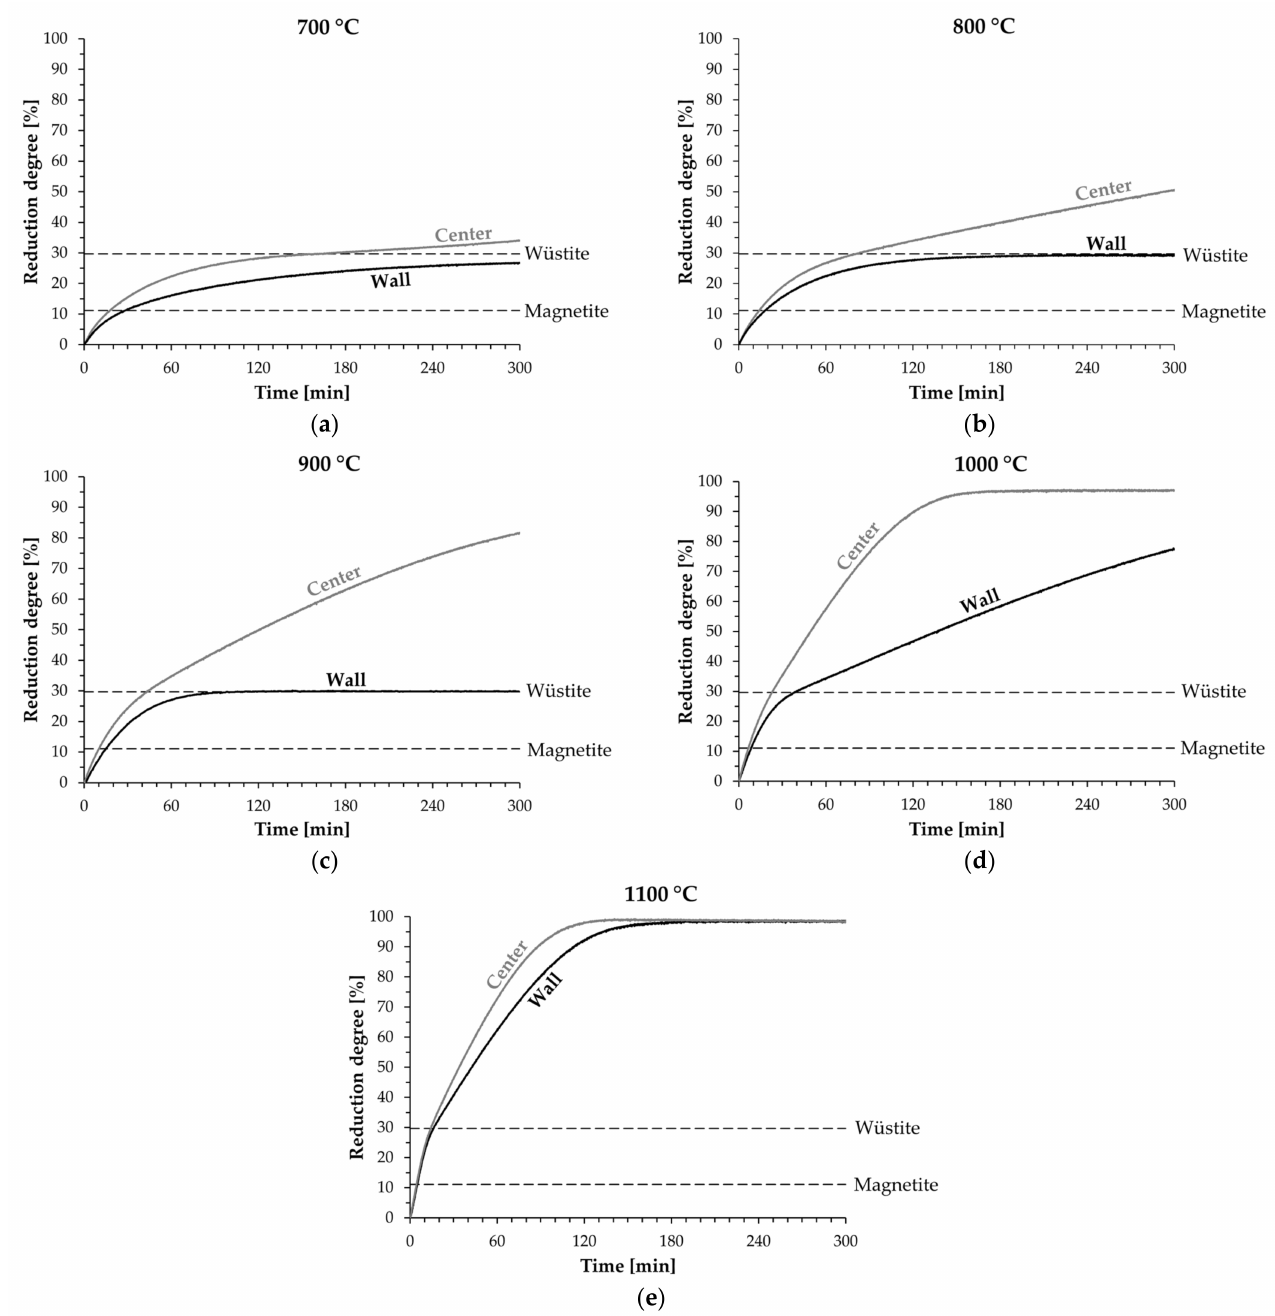
Figure 7. Reduction curves for the pellets reduced isothermally at ( a ) 700, ( b ) 800, ( c ) 900, ( d ) 1000, and ( e ) 1100 ◦ C, simulating the wall and center conditions in a CO-CO 2 -H 2 -H 2 O-N 2 gas. At each studied temperature, the pellets reduced faster using the center profile, com- pared to the wall profile because of a higher reducing potential in the gas (higher values for etaCO and etaH 2 ), which can also be seen in the Baur-Glaessner diagrams. The difference was the highest at temperatures of 900 and 1000 ◦ C. Another important implication that can be drawn from the reduction curves is that the pellets reduced faster as H 2 -H 2 O appeared in the reducing gas, compared to the CO-CO 2 -N 2